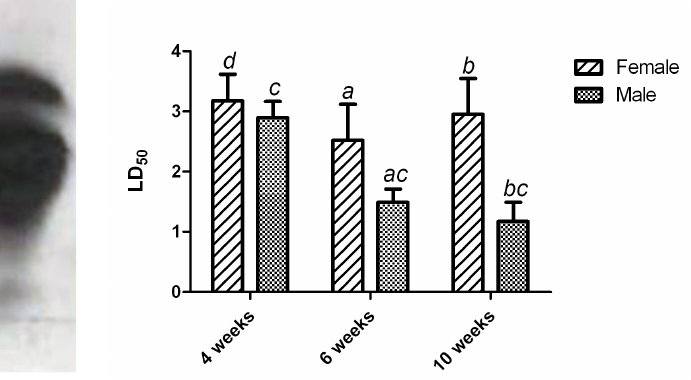
Figure 1. Electrophoretic profile of Tityus serrulatus venom. SDS-PAGE on a gradient (8-20% w/v) gel under non-reducing conditions. Lane 1: standard molecular weight markers (#SMO661; Thermo Fisher Scientific, USA). Lane 2: T. serrulatus venom (2 µg). Silver staining.